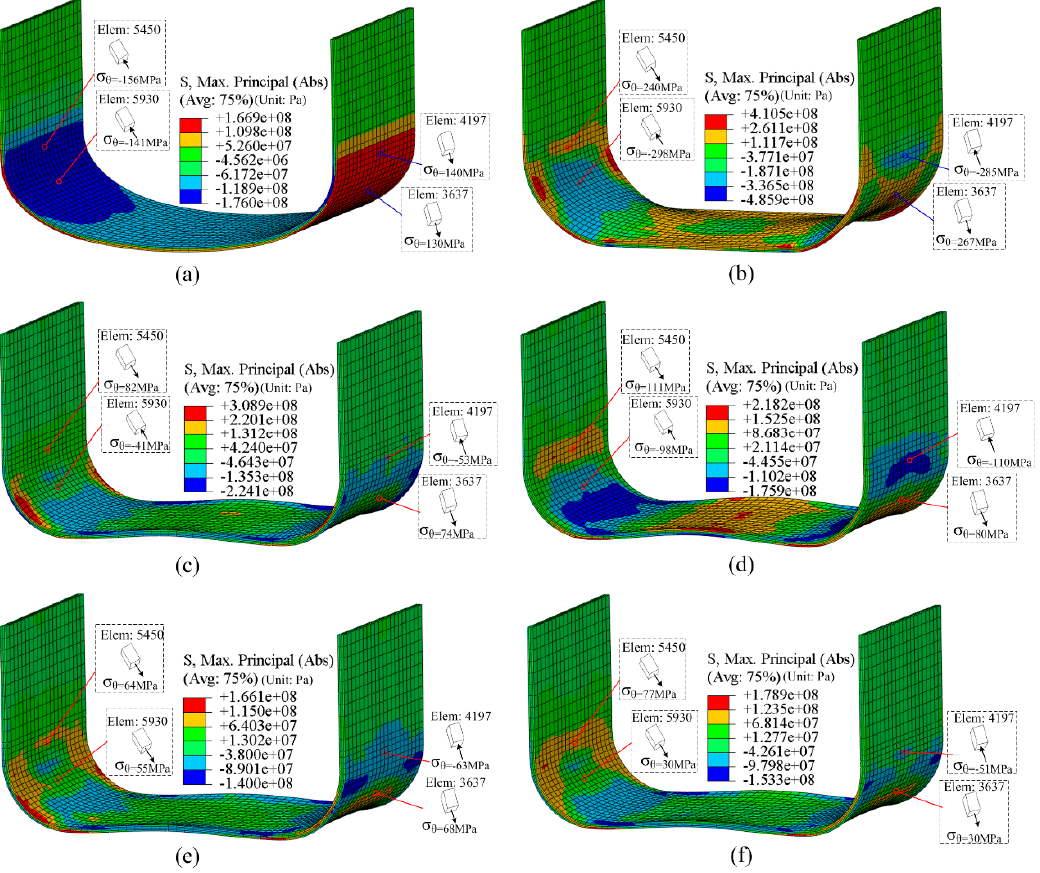
Figure 11. Distribution of tangential stresses in the sheet for 3 kV at different times: ( a ) 75 μ s, ( b ) 150 μ s, ( c ) 300 μ s, ( d ) 600 μ s, ( e ) 1500 μ s, and ( f ) 3000 μ s.